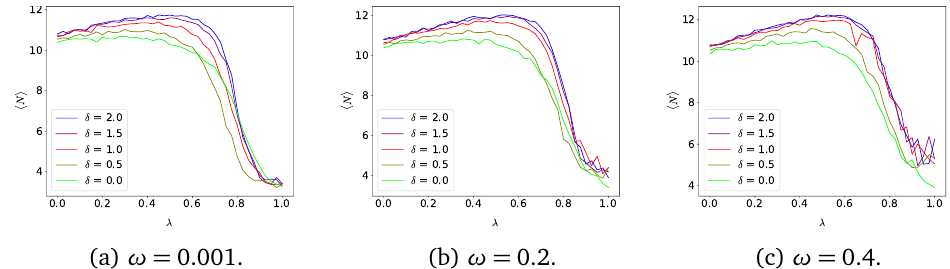
Figure 16: Plots of 〈 N 〉 versus λ for different values of ω , with Q = 20.